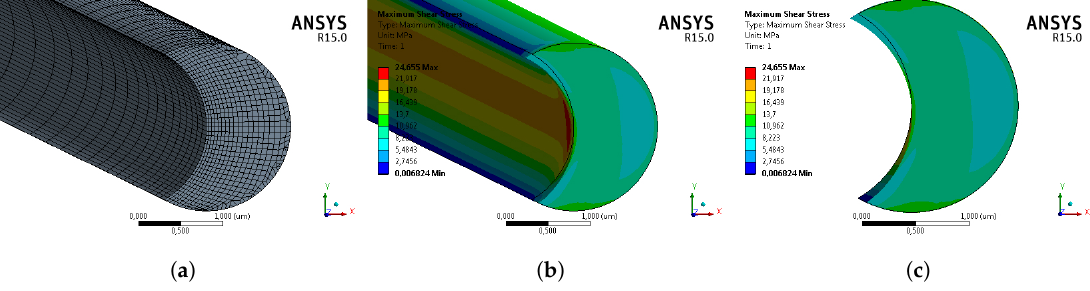
Figure 12. Summary of the results obtained by applying FEA to the case r = h : ( a ) mesh; ( b ) shear stress; and ( c ) shear stress in the